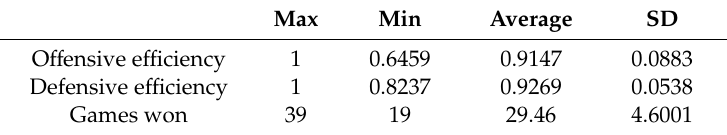
Table 4. Descriptive statistics of input-output indicators of CPBL team integration